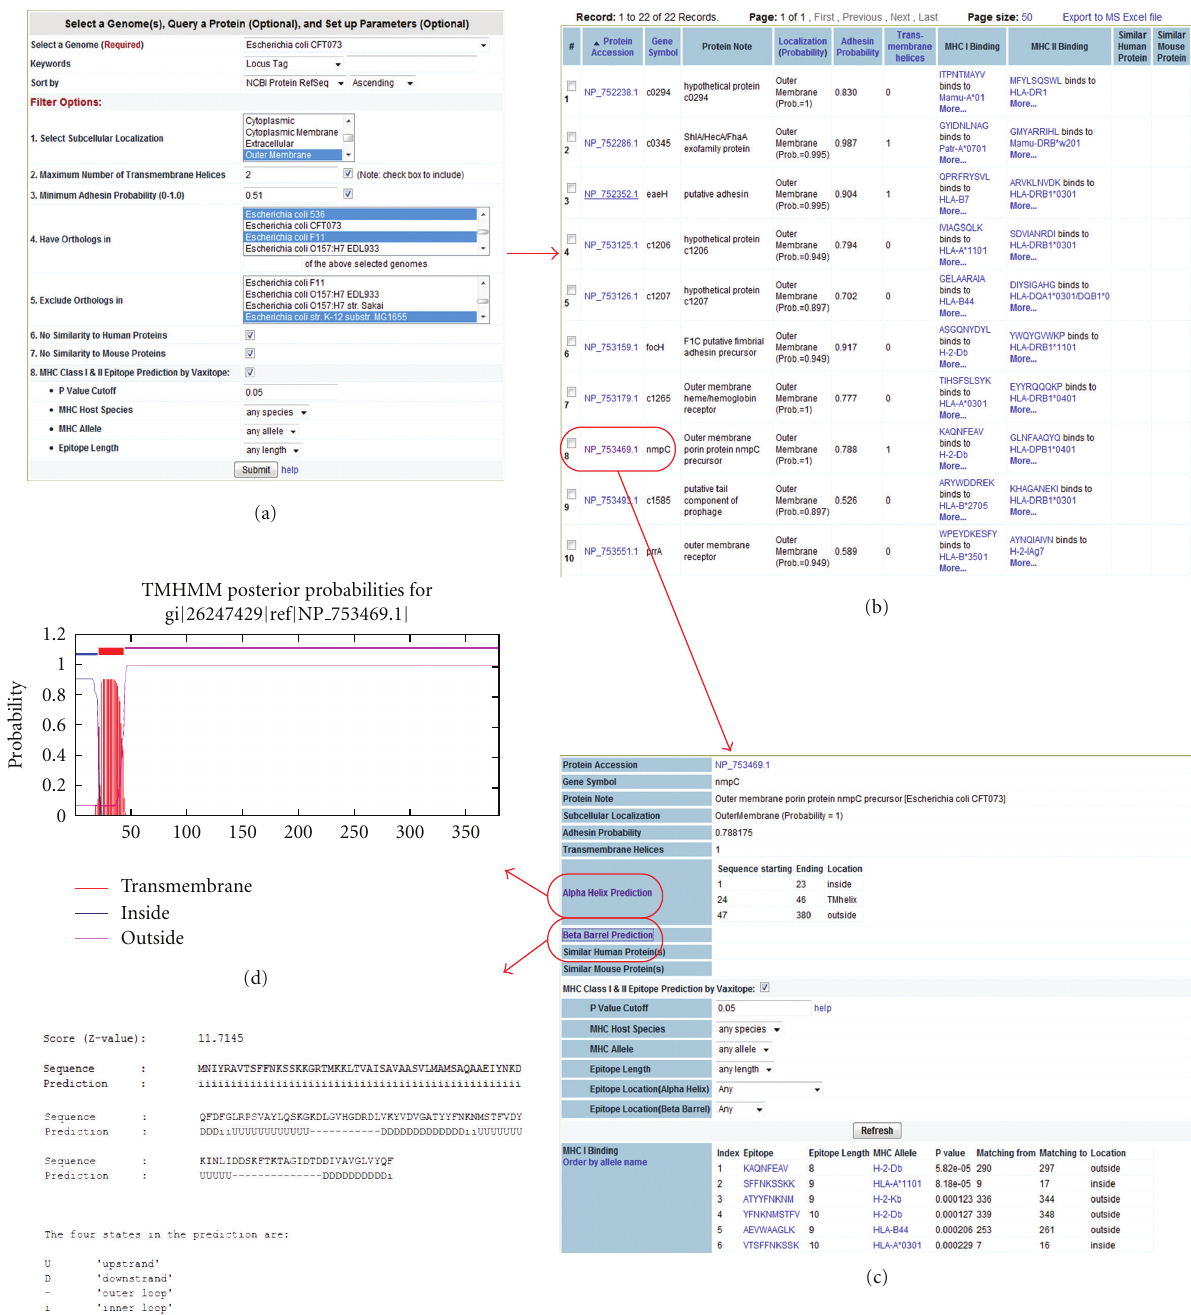
Figure 3: Vaxign prediction of UPEC vaccine targets. (a) Selection of E. coli CFT073 as a seed genome. Di ff erent filter options are applied: only outer membrane proteins, maximum of one transmembrane helix, minimum adhesin probability of.51, having orthologs in other three UPEC genomes but no orthologs in K-12 strain M1655, and no similarity to any human or mouse proteins. (b) In total 22 proteins were predicted to meet selected criteria. (c) Detailed results for a particular protein, for example, NmpC. MHC Class I and II epitope prediction results are also available and can be further filtered. (d) Prediction of α -helices and their possible cellular locations of NmpC. (e) Prediction of β -barrels and their possible cellular locations of